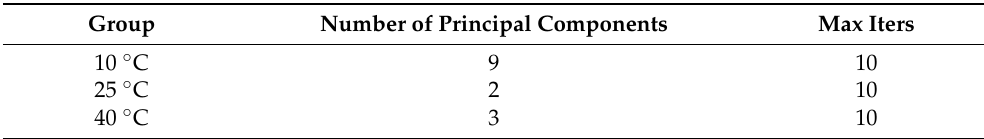
Table 2. The optimum parameter of the PLS model.